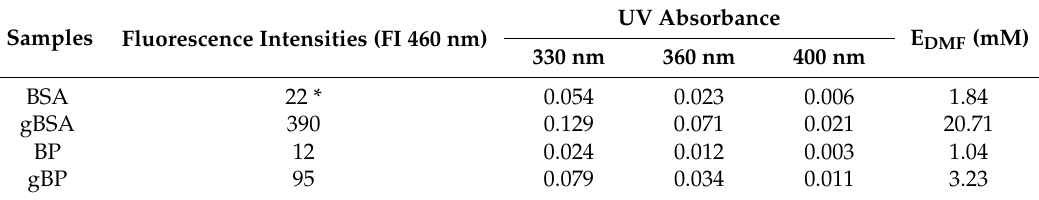
Table 1. Detection results of the glycation